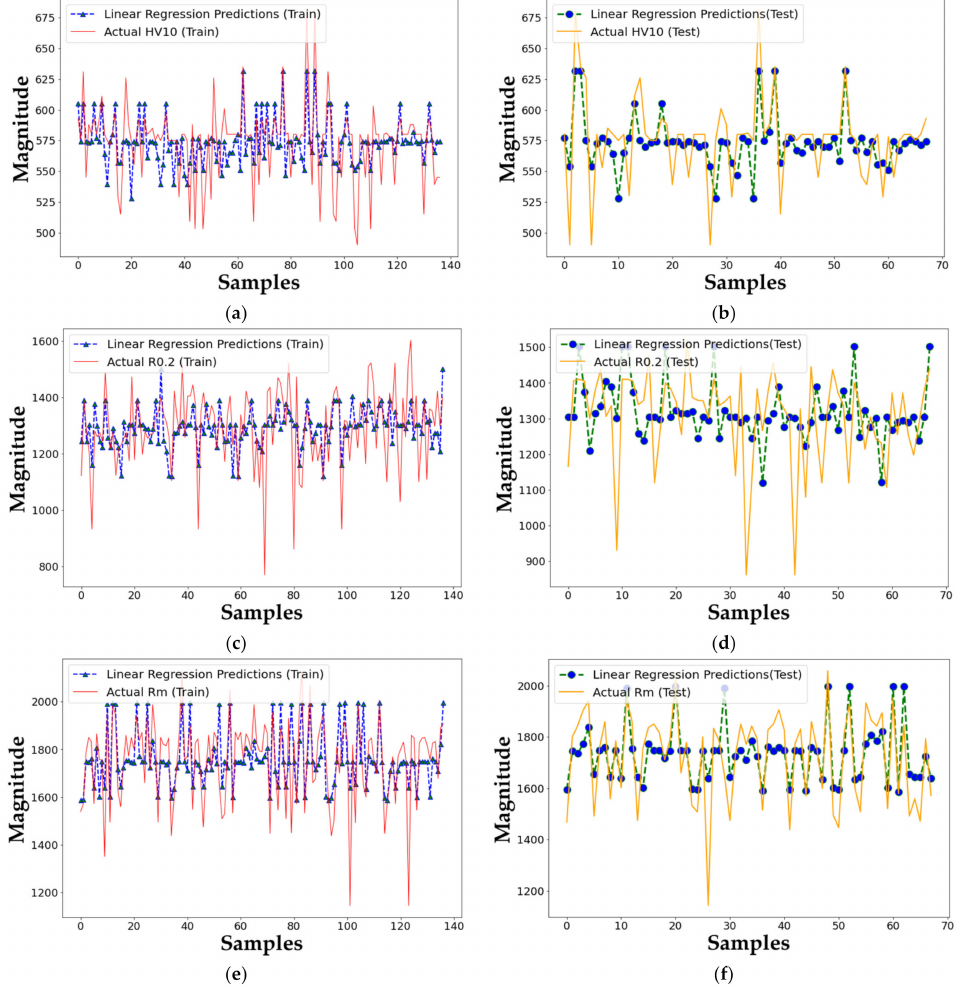
Figure 5. Evaluation of the ML Linear Regression in modelling the digital twins of the alloy based on HV10 ( a ) and ( b ); R0.2 ( c ) and ( d ); Rm ( e ) and ( f ) in the presence of all inputs, including heating, QT, PT, and Pt; ( a , c , e ): Train and ( b , d , f ):